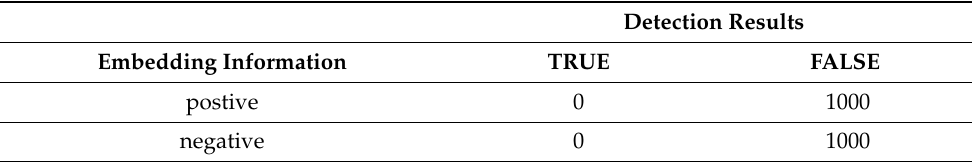
Table 5. Confusion matrix of SRNet’s detection results.